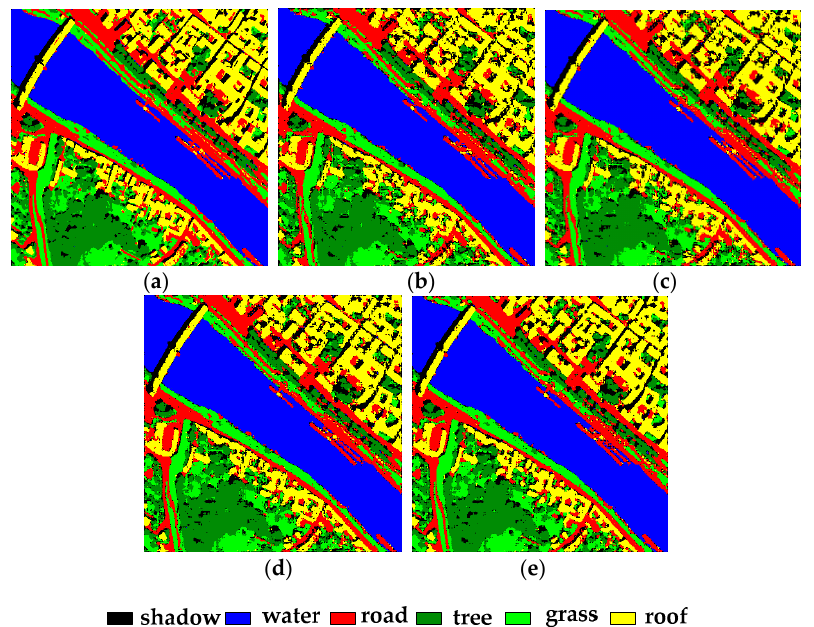
Figure 9. ( a ) RGB composites of image (bands 102, 56, and 31 for red, green, and blue, respectively). ( b ) Coarse image ( 4 S = ). ( c ) Panchromatic image. ( d ) Pansharpening result.